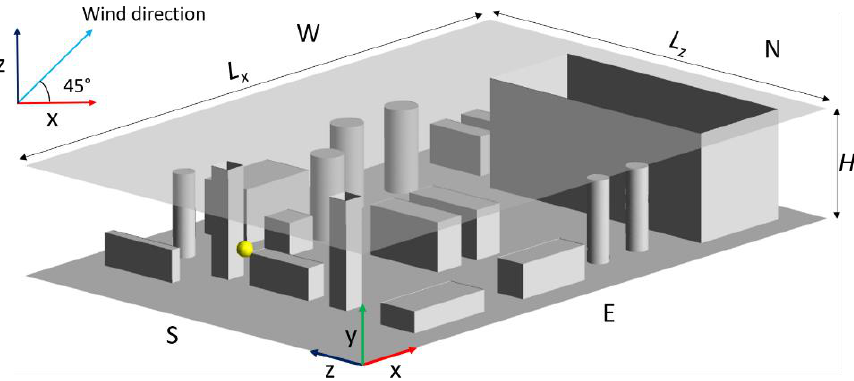
Figure 1. Geometry of the platform production deck, with the release point in yellow and a schematic representation of the wind direction.